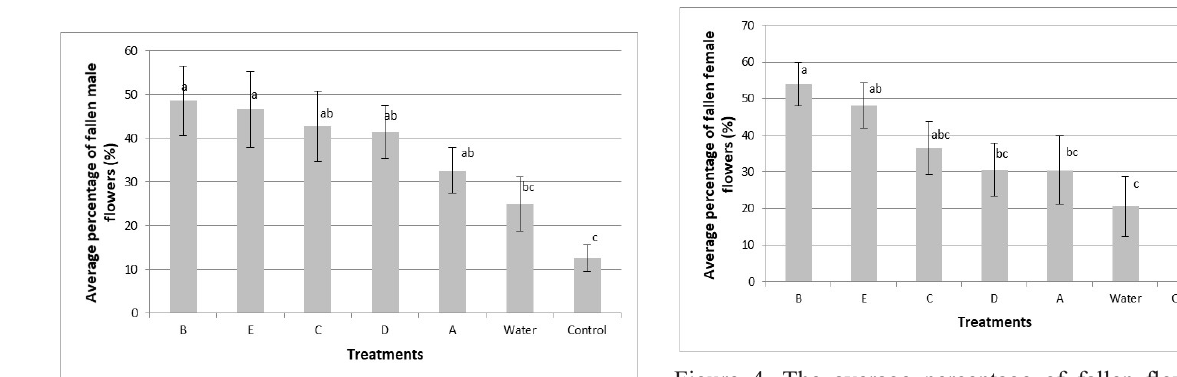
Figure 4. The average percentage of fallen flowers in female plants, standard error and Tukey test for the different treatments. Virú. La Libertad. Perú, May-June. 2008.